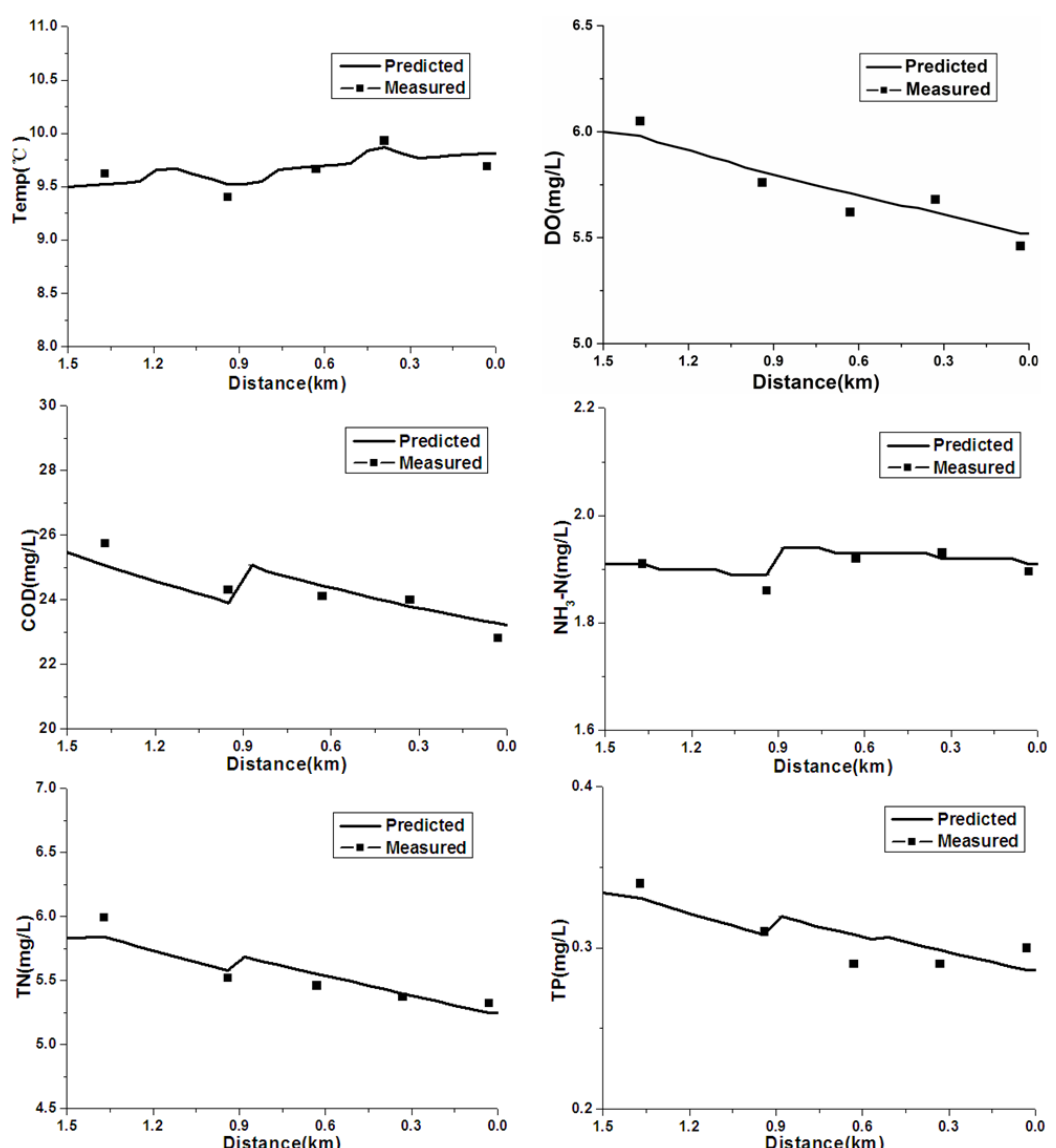
Figure 4. Water quality calibration results for the Hongqi